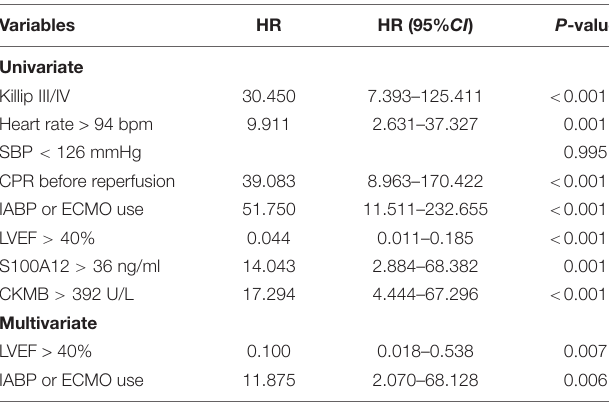
TABLE 3 | A univariate and multivariate logistic regression model evaluating the association of clinical factors with in-hospital mortality in our validated cohort.